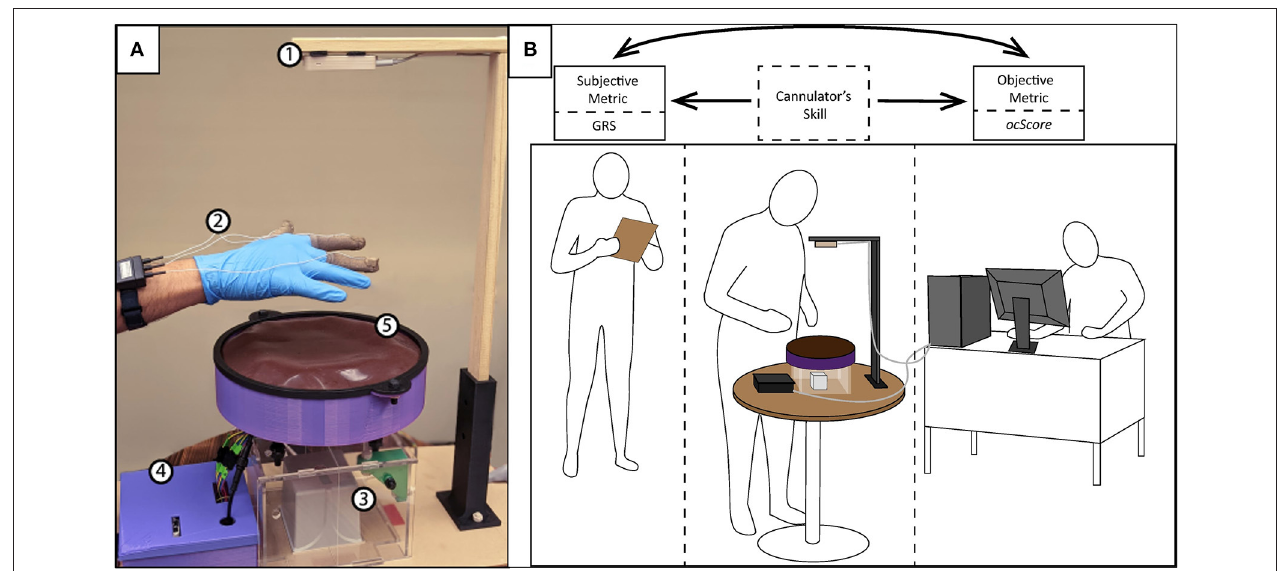
FIGURE 1 | (A) The physical simulator with the following components: (1) Leap Motion Controller, (2) FingerTPS, (3) Motion tracker unit, (4) Control Box, and (5) Simulator skin surface; (B) Experimental setup with cannulator (PCT or nurse) using the simulator (in the middle), the preceptor using the GRS rating sheet (to the left), and the operator for the simulator (right).